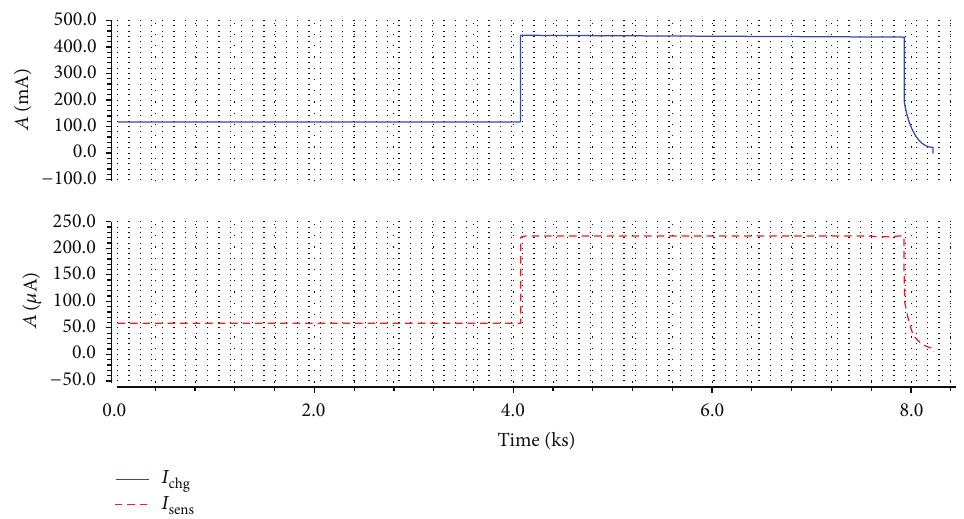
Figure 9: Simulation results of sensing currents; from top to bottom, the waveforms are the charging current 𝐼 respectively.